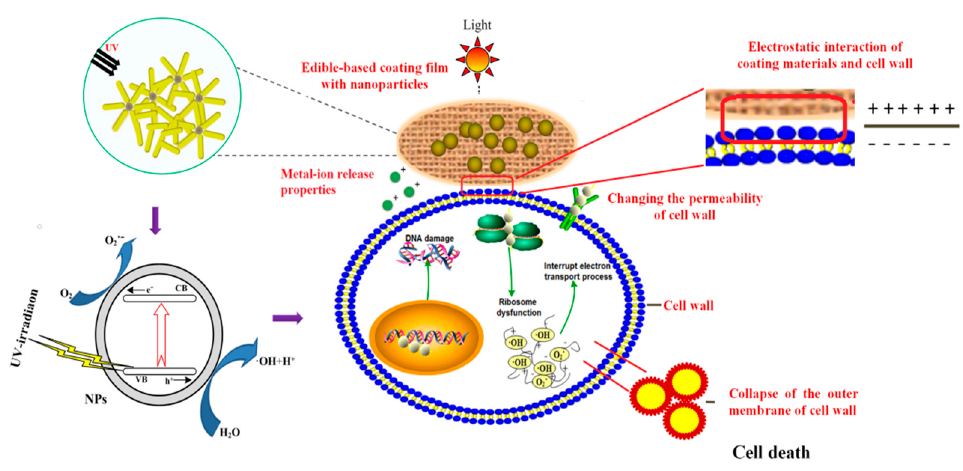
Figure 5. Proposed antimicrobial mechanism of ECF (such as chitosan-based coating) with NPs. According to Davoodbasha et al. [17], the bactericide containing CS and AgNPs was able The primary mechanism for antimicrobial activity of CS relies on the interaction between the